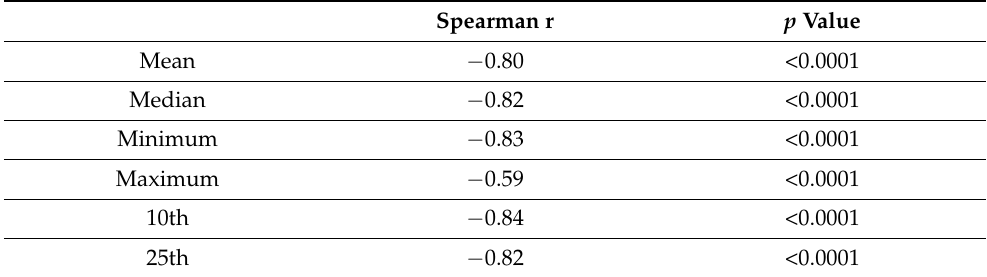
Table 5. Between-subjects Spearman correlation coefficients for correlations between ADC parameters and Gleason